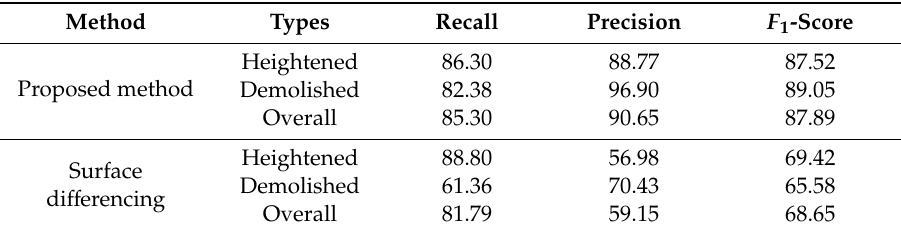
Table 5. Pixel-based change detection results of Enschede data (%).